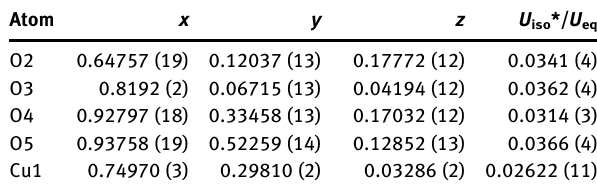
Table  : Fractional atomic coordinates and isotropic or equivalent isotropic displacement parameters (Å 